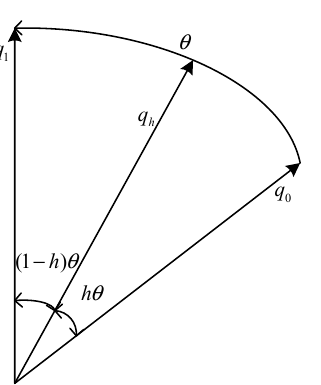
Figure 2. Spherical linear interpolation between 2 postures.